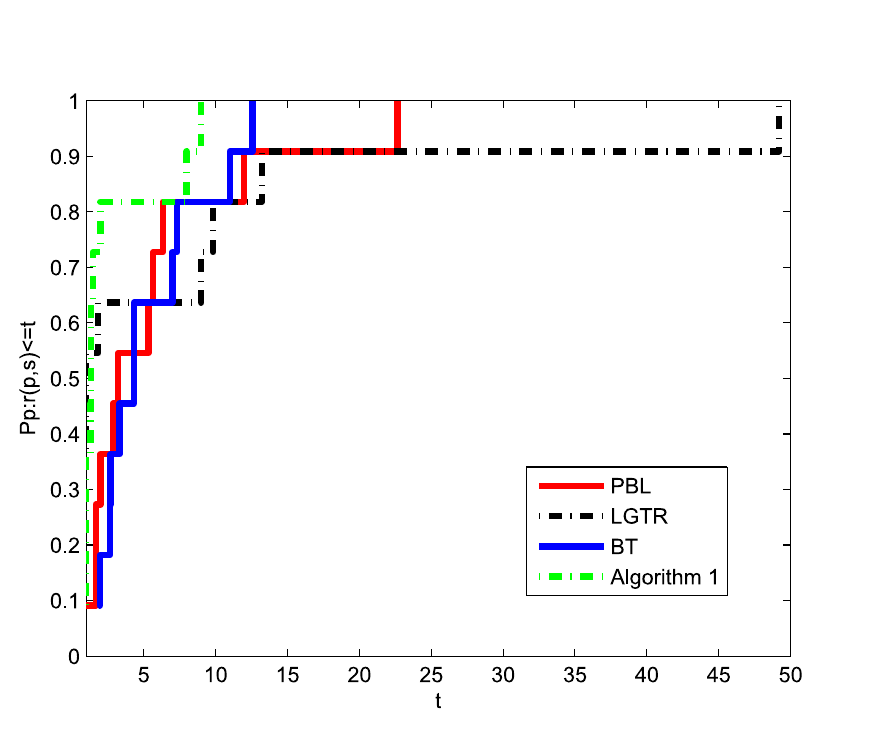
Fig 2. Performance profiles of these methods